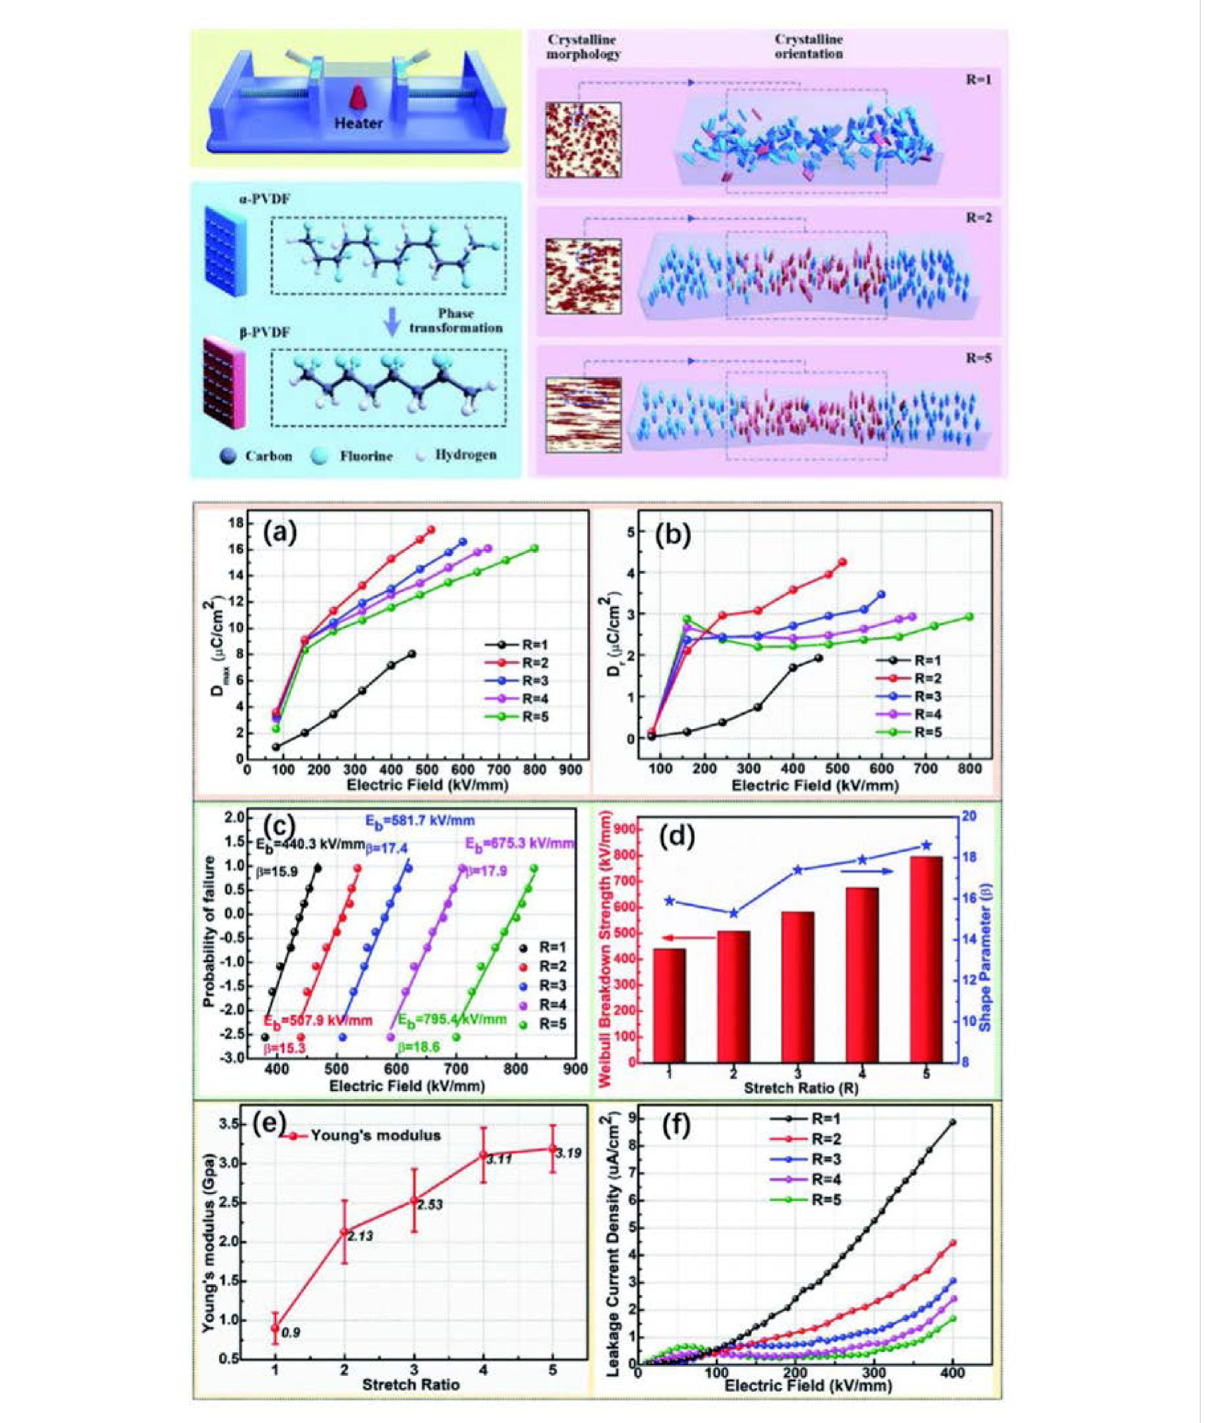
FIGURE 13 Schematicillustrationoftheuniaxialstretchingprocessandstructuraldevelopmentwithincreasingstretchratio,and (A) Themaximumelectric displacementand (B) remnantelectricdisplacementofthePVDF fi lmsasafunctionoftheelectric fi eld; (C) Weibulldistributionofelectricbreakdown strength; (D) The characteristic breakdown strength and shape parameters of the PVDF fi lms with different stretch ratios; (E) Young ’ s moduli of the PVDF fi lms with different stretch ratios; (F) Leakage current density of the PVDF fi lms. Reproduced with permission from Ref. 111. Copyright 2021 The Royal Society of